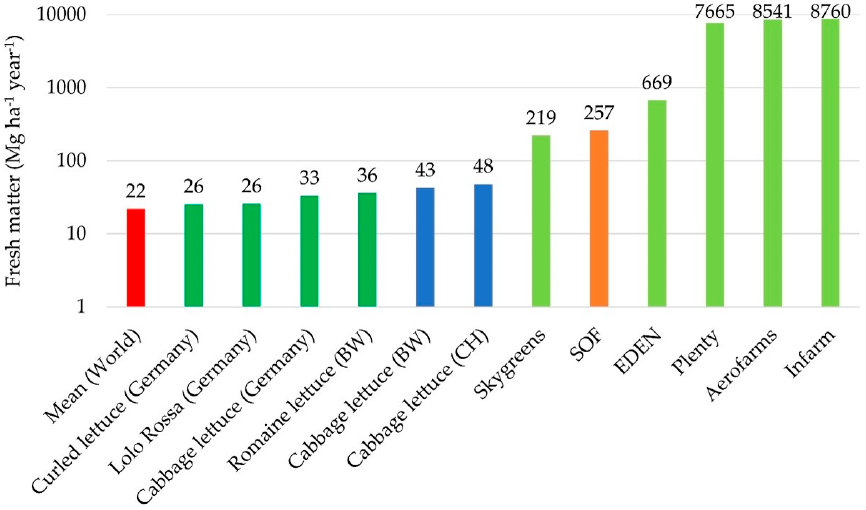
Figure 10. Comparison of yield; Mean World (red); field conditions (green); greenhouse (blue); SOF (orange); vertical farming companies (green).